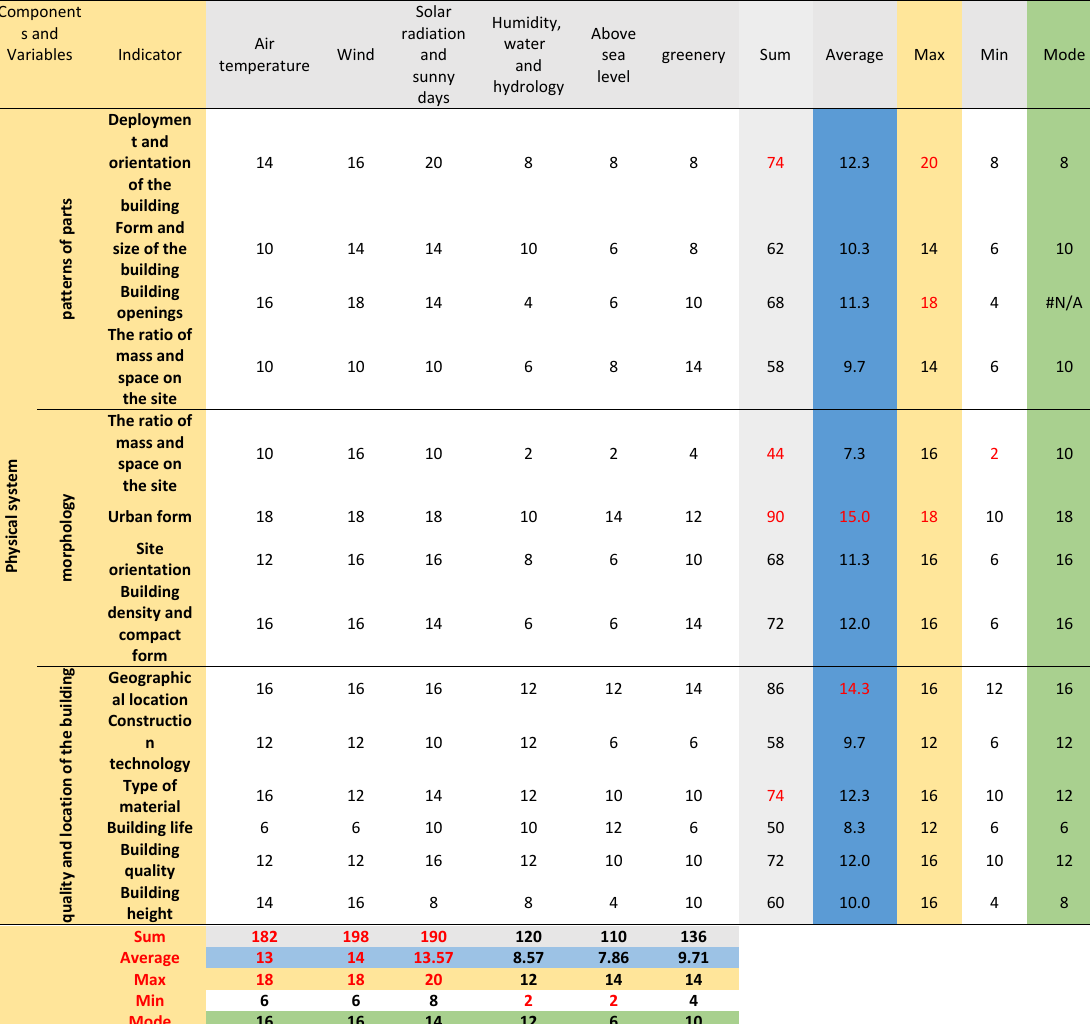
Table 4: Relation between the and climate indicators